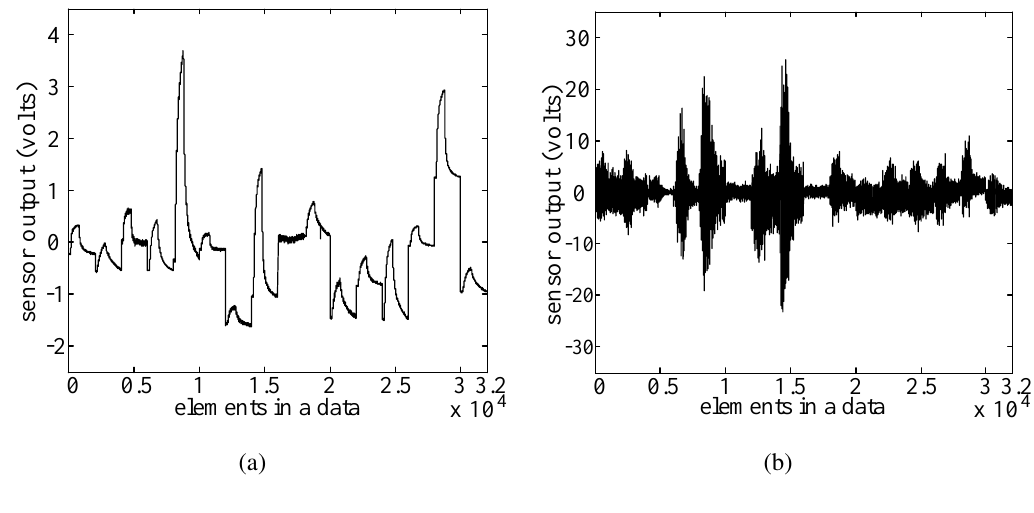
Figure 7. Electronic nose data w/o and with Gaussian noise. ( a ) Electronic nose data without noise. ( b ) Data with Gaussian noise (std 3).